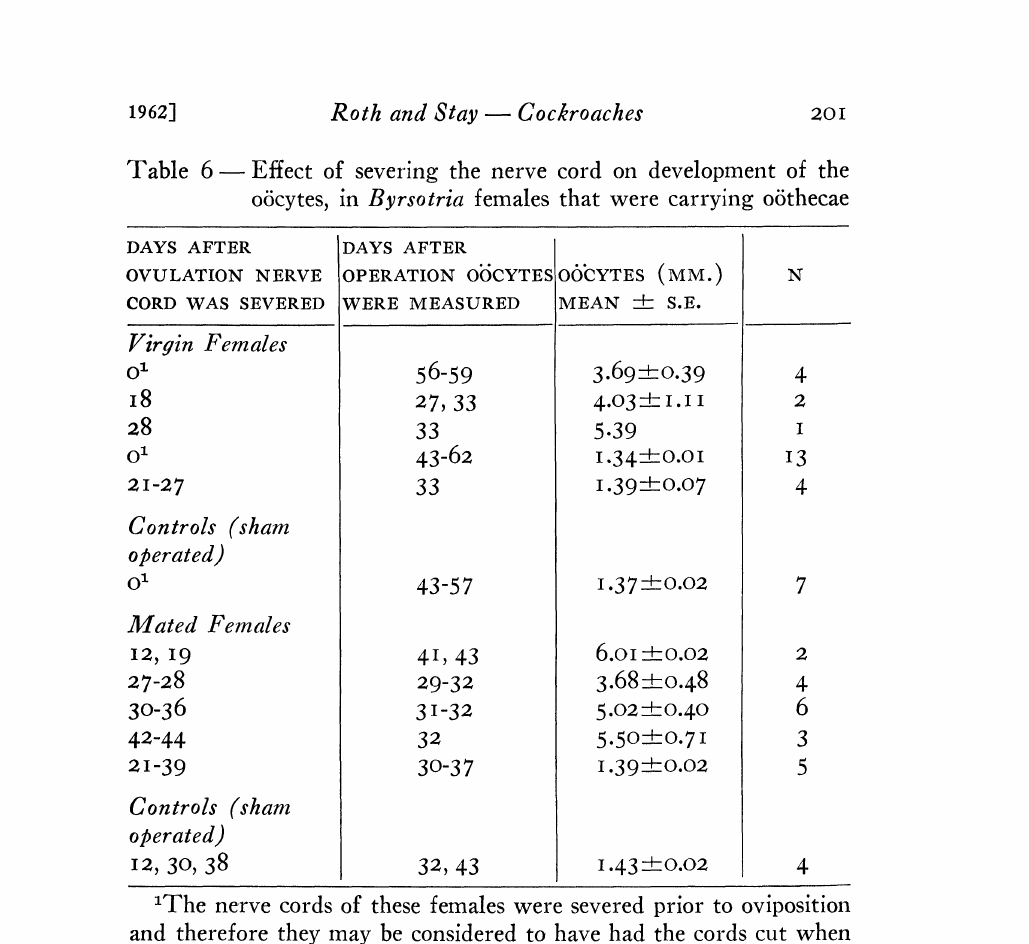
Effect of severing the nerve cord on development of the o6cytes, in Byrsotria females that were carrying o6thecae DAYS